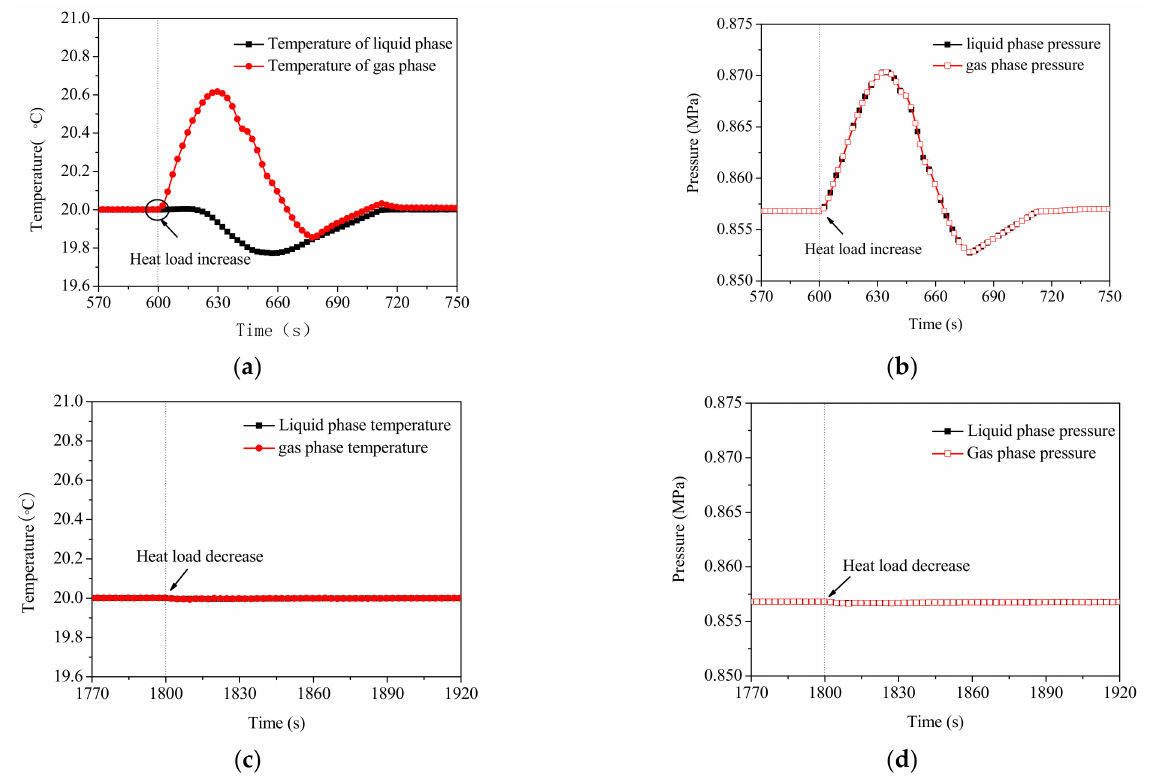
Figure 6. Temporal evolution of temperature and pressure of two-phase fluid in an accumulator in response to heat load ( a , b ) increase and ( c , d )